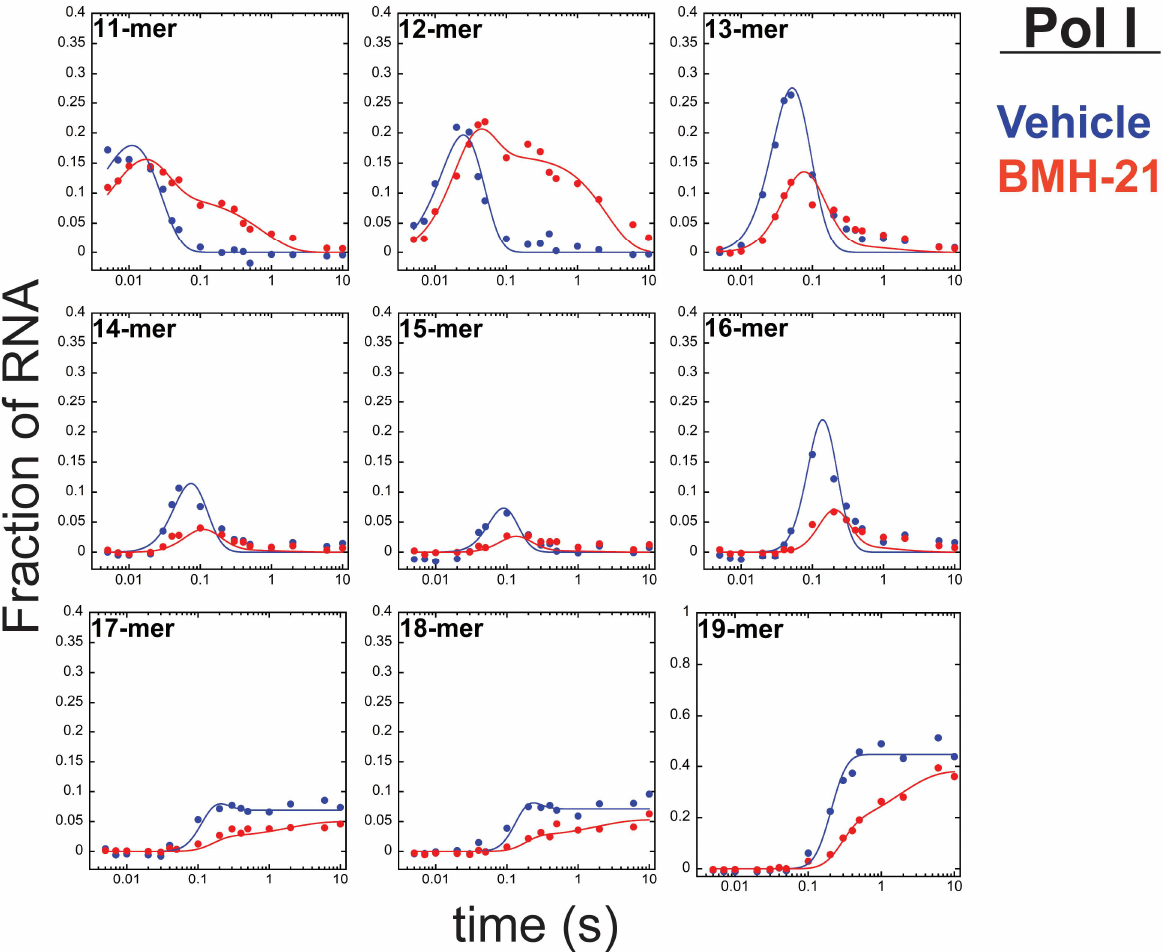
Figure 2. Pol I multi-nucleotide addition in the presence of vehicle or BMH-21. Representative data sets of the fraction of each RNA species over time fit to their respective schemes, Scheme 1 for vehicle-treated and Scheme 2 for